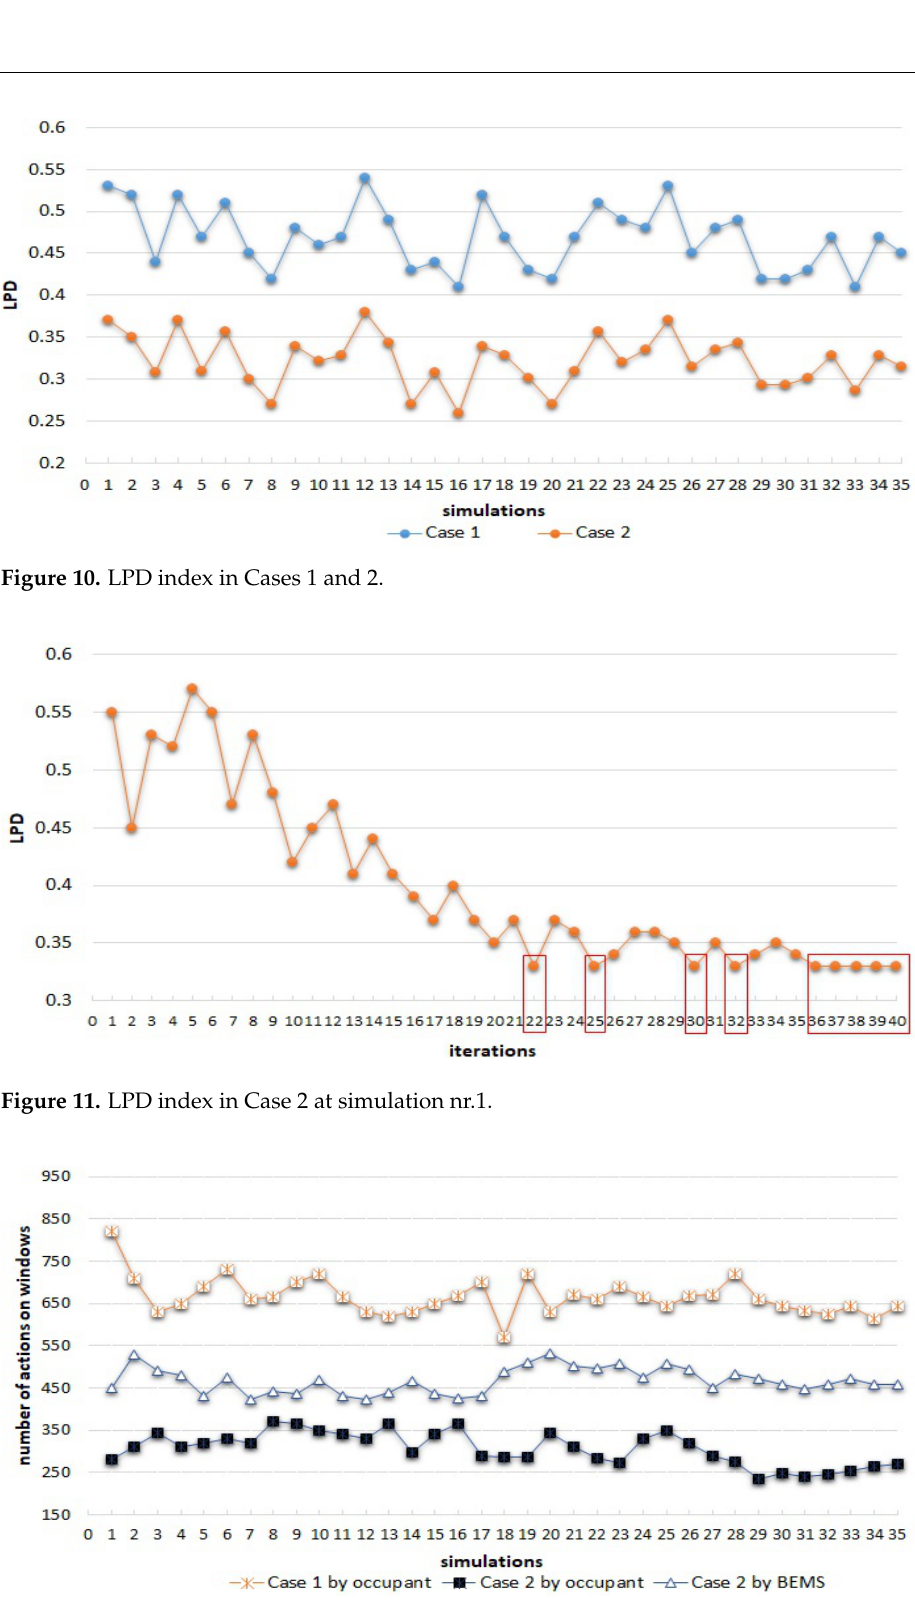
Figure 12. Number of actions of window opening for Cases 1 and